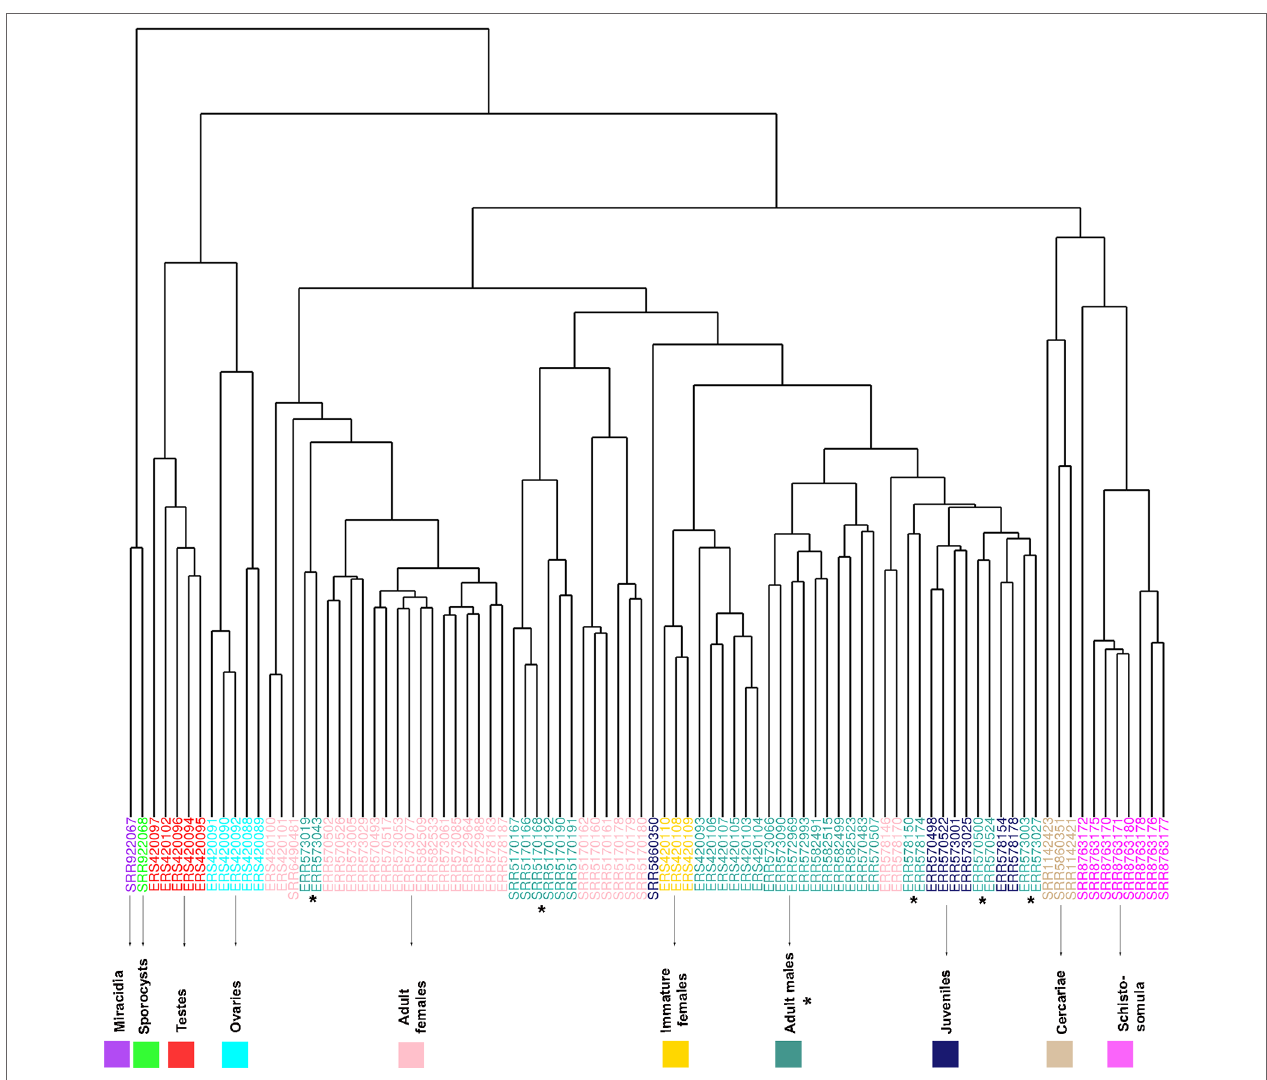
FIGURE 6 | RNA-seq samples clustering based on Euclidian distance according to the expression levels of all genes used for WGCNA. The expression levels of all lncRNA and mRNA genes from all RNA-seq data sets analyzed in the WGCNA were used for unsupervised clustering of the samples, including RNA-seq data sets from adult females (pink), adult males (turquoise), cercariae (tan), immature females (gold), juveniles (midnight blue), miracidia (purple), ovaries (cyan), schistosomula (magenta), sporocysts (green), and testes (red). The SRA or ENA accession number for each RNA-seq library is indicated at each leaf. The asterisks mark the adult male data sets, whose clustering pattern is the most spread